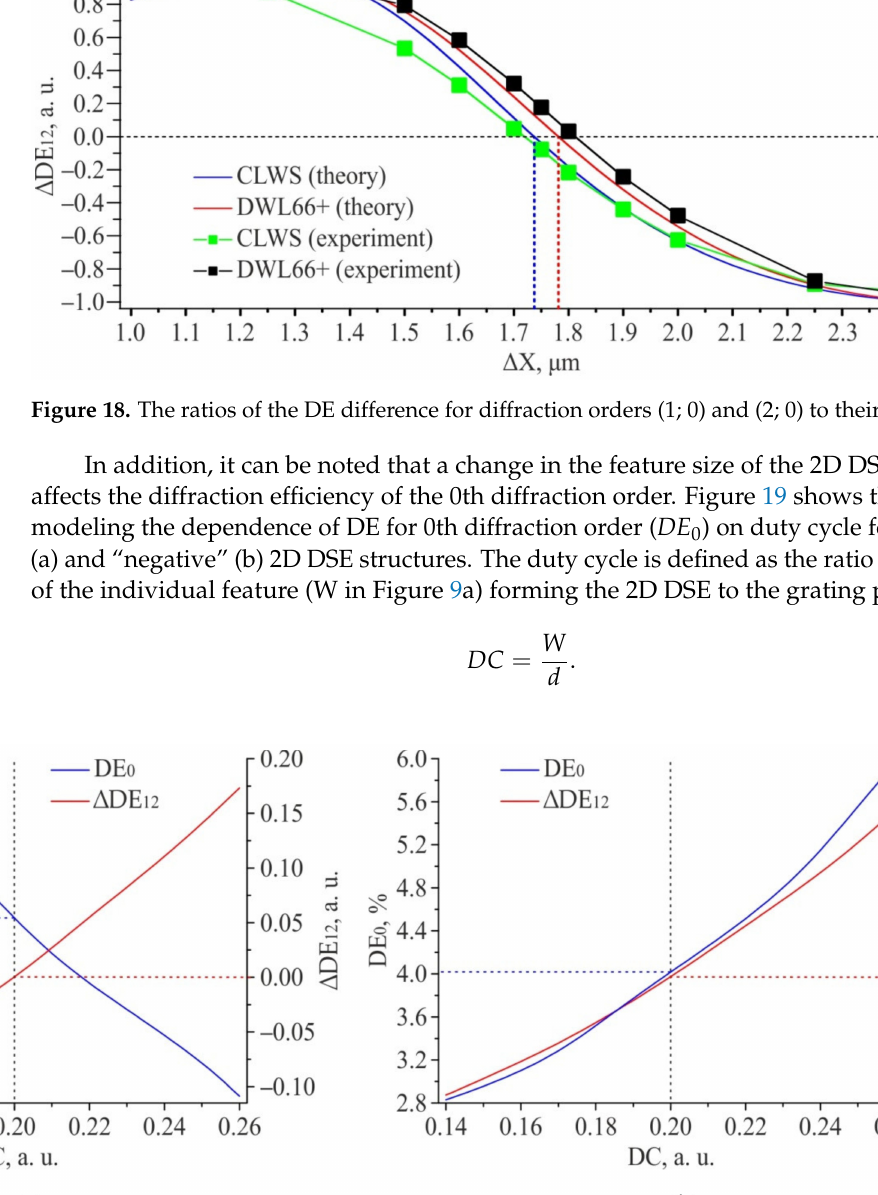
Figure 19. Influence of the feature size in the 2D DSE on the DE of the 0th diffraction order and parameter ∆ DE 12 : “Positive” 2D DSE ( a ); “Negative” 2D DSE ( b